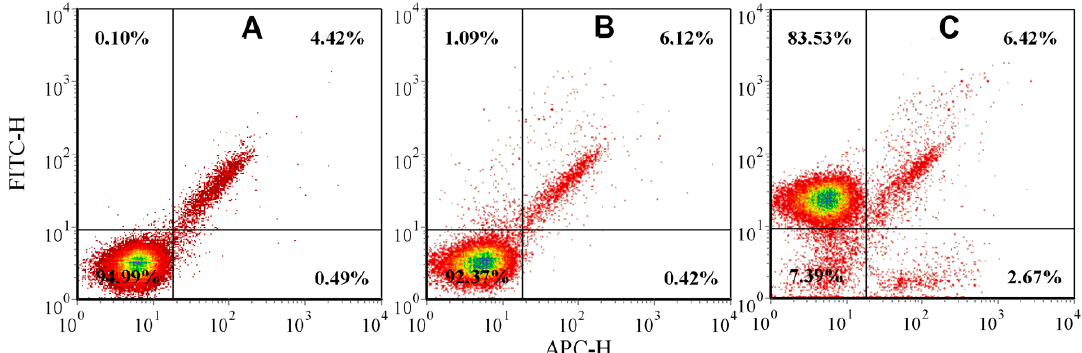
Figure 3. Flow cytometry-based analysis of the T-lymphocytic antigen CD5 in the human T-lymphoblast cell line MOLT-4 where: ( A , B , C ). Flow cytometric quadrant analysis of the MOLT-4 cell line: autofluorescence of cells ( A ), anti-IgG2a-FITC labeled cells ( B ), anti-CD5-FITC labeled cells ( C ). Upper quadrants: IgG2a-positive ( B ) or CD5-positive cells ( C ).